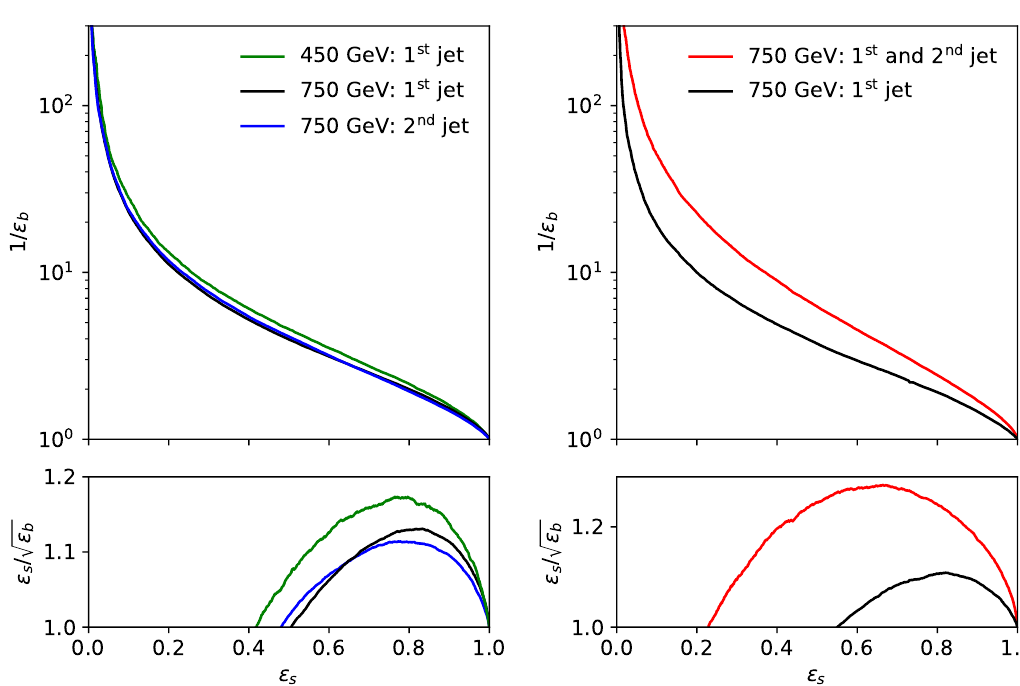
Figure 10: Left: ROC and SI curves for a 250 ... 300 GeV jet from a 450 GeV Z (cid:48) resonance and for 300 ... 400 GeV jets from a 750 GeV Z (cid:48) resonance, using the model trained on pure samples. Right: performance improvement from considering both decay jets from a 750 GeV Z (cid:48) resonance, based on a dedicated